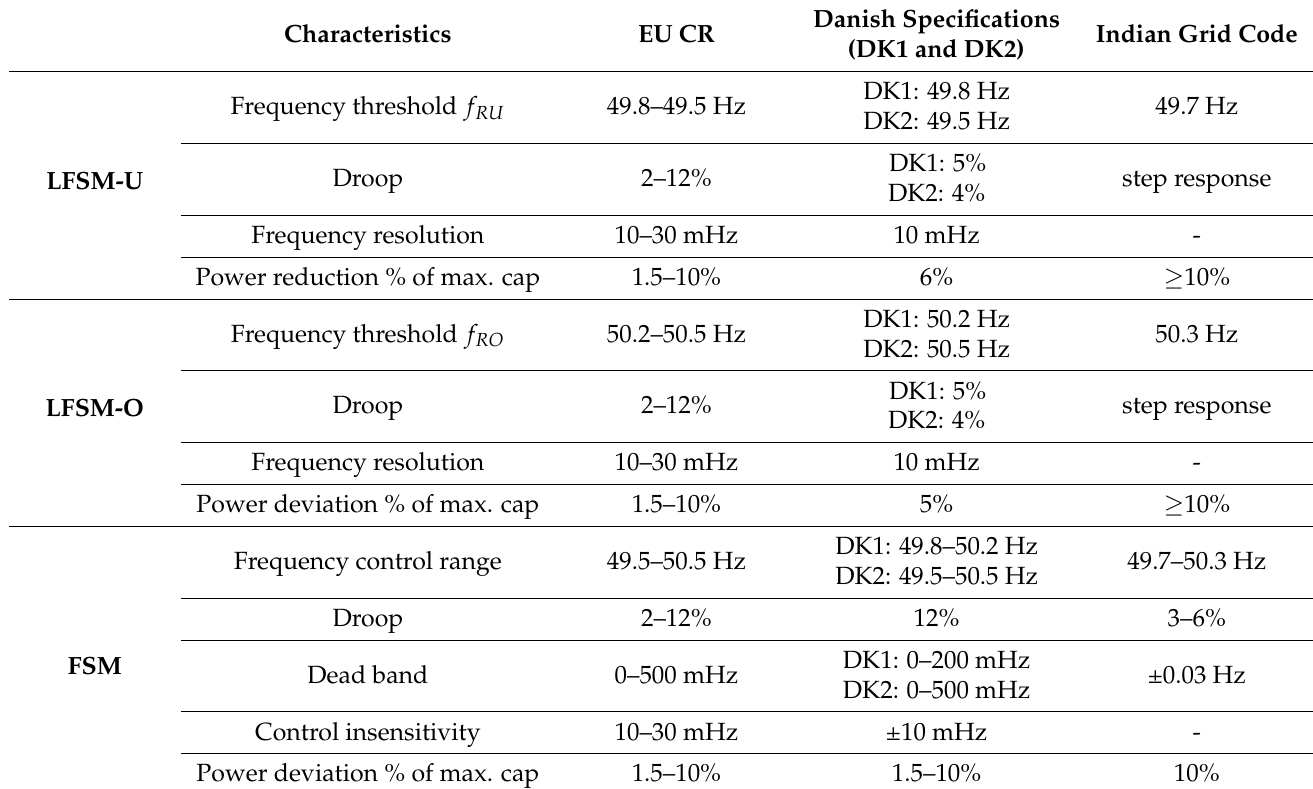
Table 4. Defaults settings for frequency response LFSM-U, LFSM-O and FSM in Europe, Denmark and